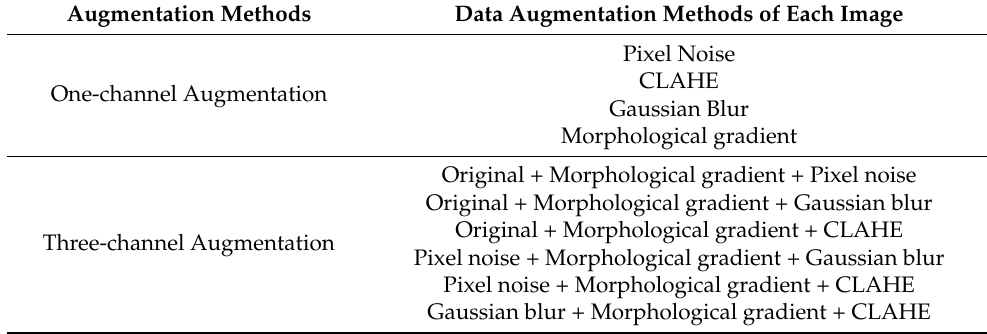
Table 2. Proposed data augmentation methods.